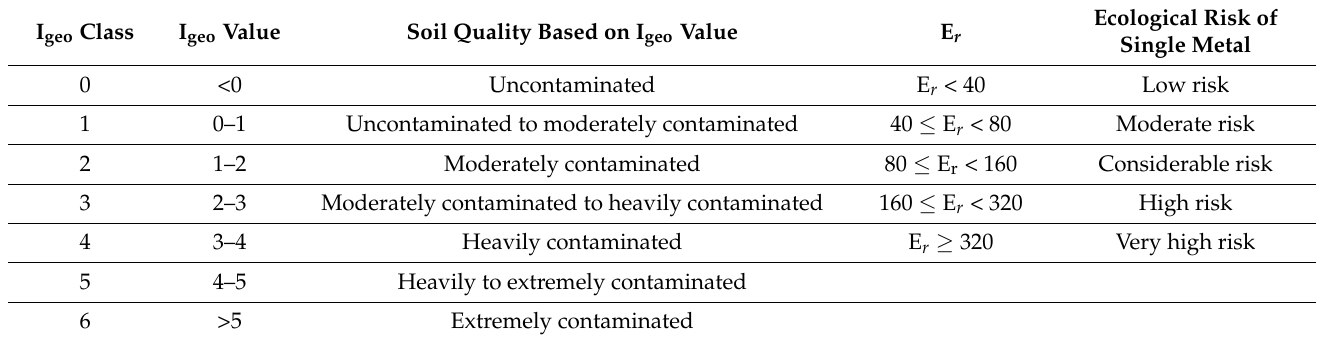
Table 2. Classes of metal contamination, I geo [39], and the ecological risk for metal pollution, E r ,